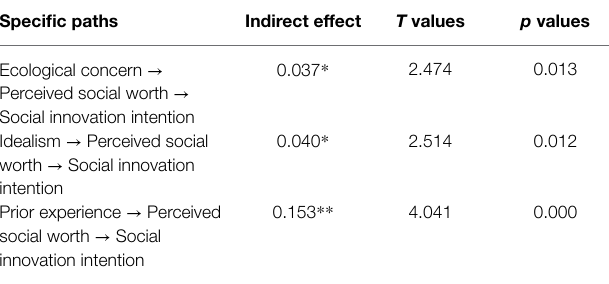
TABLE 5 | Analysis of perceived social worth indirect effect